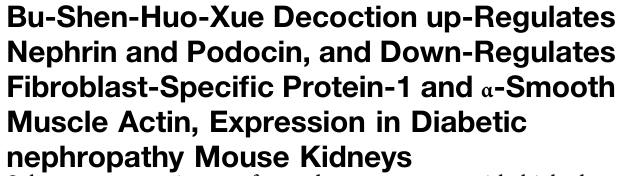
Frontiers in Pharmacology |